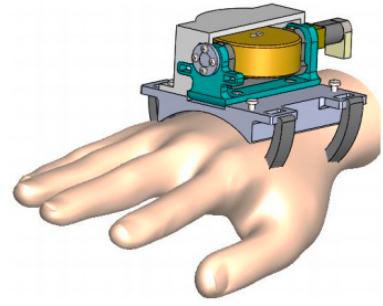
Figure 8. The conceptual 3D design of the proposed approach.